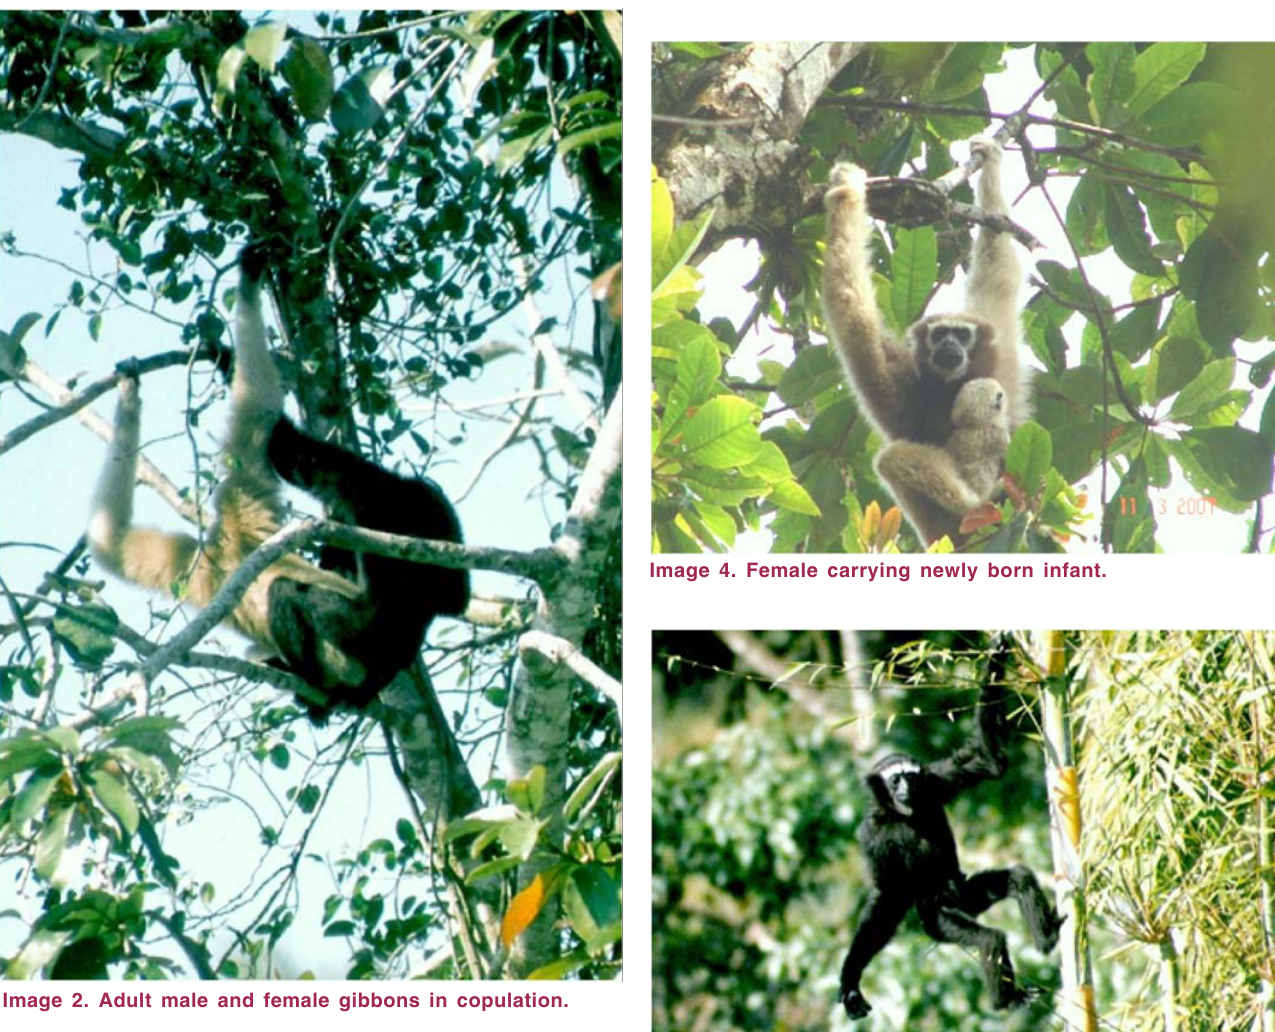
Image 5. Juvenile male in bamboo